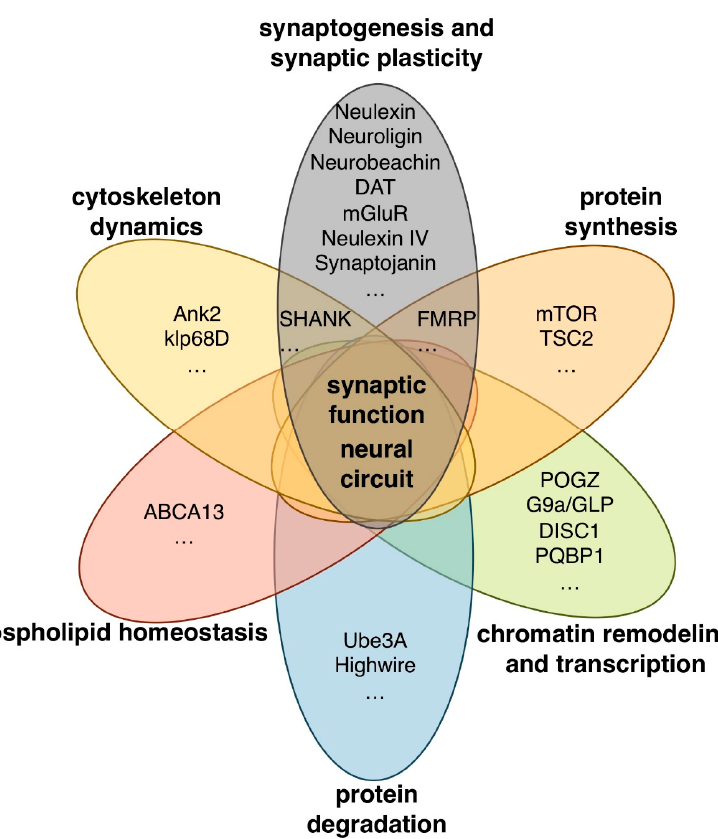
Figure 1. Human autism spectrum disorder (ASD)-associated genes with various biological functions.